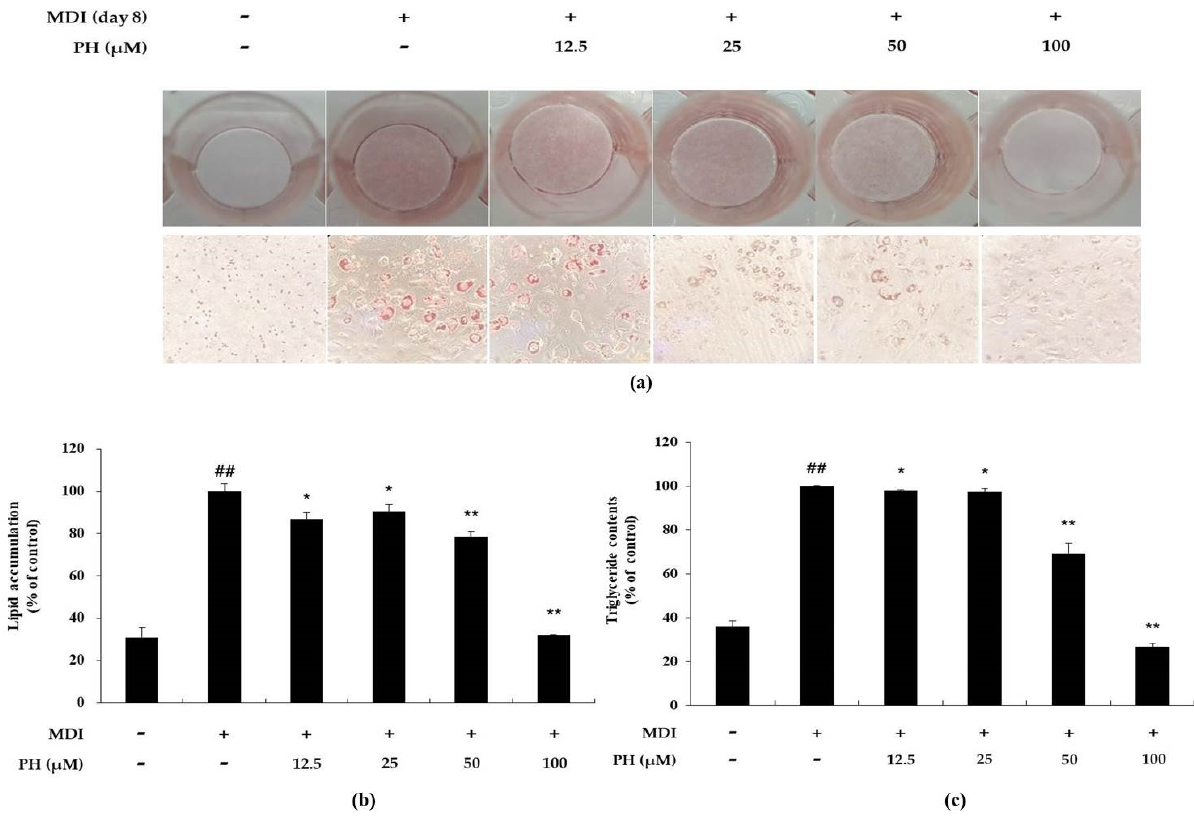
Figure 2. Effect of PH on lipid accumulation and triglyceride content in 3T3-L1 adipocytes. Adipocyte differentiation was induced in post-confluent cells using MDI differentiation medium, and the cells were treated with the indicated concentrations of PH for 8 days. ( a ) Differentiated adipocytes were stained using Oil Red O on day 8 and the cells were visualized by microscopy with 100× magnification. ( b ) The stained lipid droplets were dissolved using 2-propanol and measured using a spectrophotometer to quantify lipid accumulation. ( c ) The reduction in TG content was quantified using the EZ-triglyceride quantification assay kit. Lipid accumulation and TG content are expressed as percentages relative to the control group treated with MDI alone. All values are presented as the mean ± standard deviation. ( n = 3 per group). * p < 0.05, ** p < 0.01 indicate significant differences versus the MDI-only control. ## p < 0.01 indicates significant differences versus an untreated control.